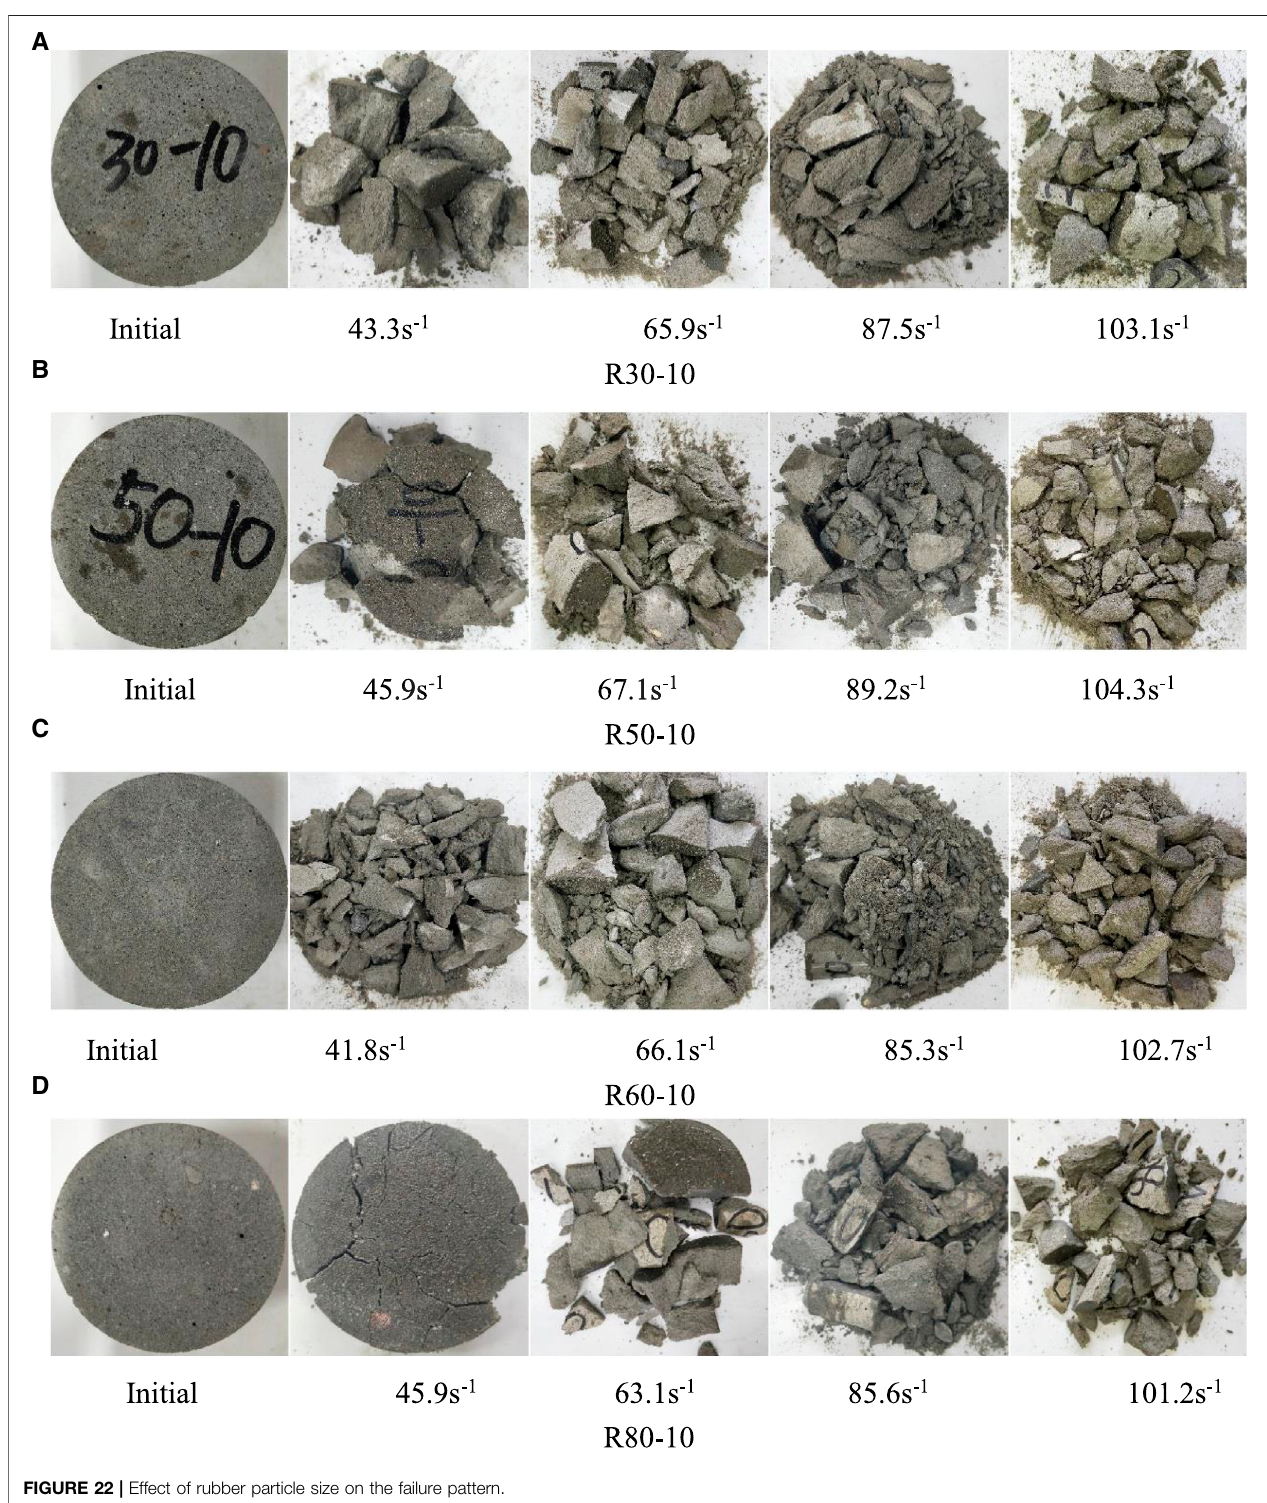
FIGURE 22 | Effect of rubber particle size on the failure